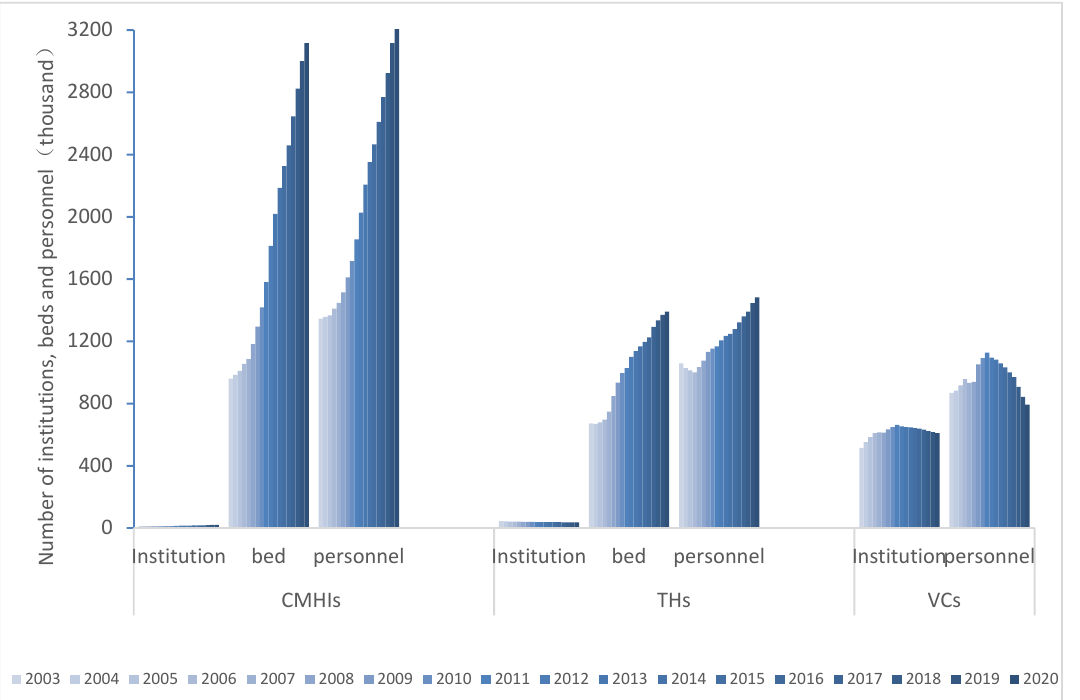
Figure 1. The past trend of resource allocation in China’s rural three-tier healthcare system from 2003 to 2020 (CMHIs: county and county-level city medical and health institutions; THs: township hospitals; VCs: village clinics).